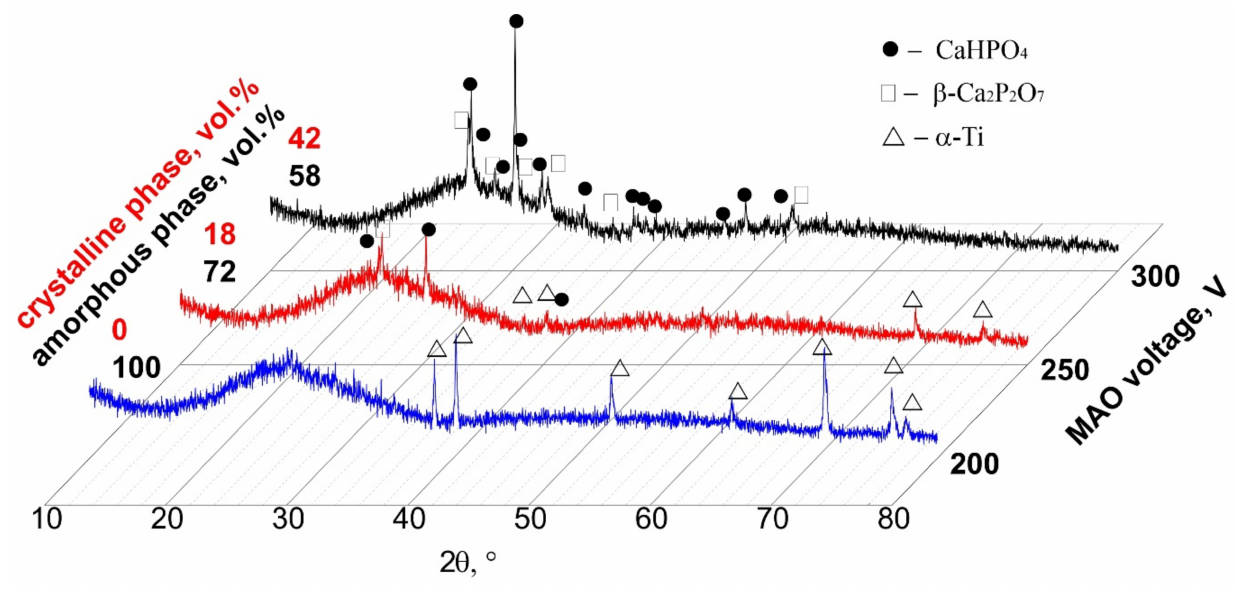
Figure 2. XRD patterns of the MAO CaP coatings formed at 200, 250, and 300 V. The TEM studies revealed that the MAO CaP coatings deposited at different voltages had an amorphous–nanocrystalline microstructure. Bright field (BF) and dark field (DF) TEM images with selected area electron diffraction (SAED) patterns for fragments of the MAO coatings are shown in Figure 3. Both diffused halos from the amorphous phase and weak point reflexes from crystalline phases were observed in SAED patterns (Figure 3b). The interpretation of the SAED patterns revealed the same crystalline phases that were observed in XRD patterns (Figure 2): β -Ca 2 P 2 O 7 (ICDD #09-0346), CaHPO 4 (ICDD #09- 0080) and TiO 2 anatase (ICDD #21-1272). The nanosized crystallites of the CaHPO 4 phase in the reflex (112) along the boundaries of the coating particles are observed in the DF TEM images (Figure 3c). Reflexes of TiO 2 anatase observed on SAED (Figure 3b) correspond to the oxide intermediate sublayer in the interface with the Ti